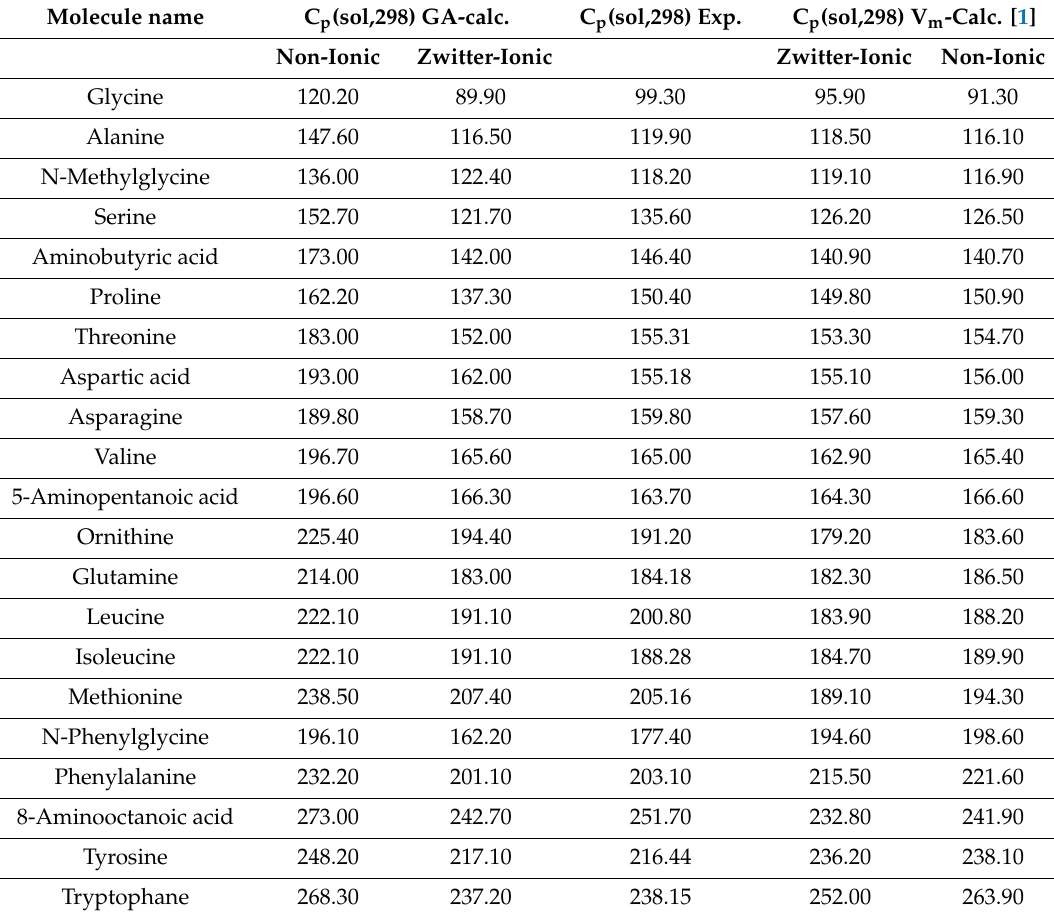
Table 10. Comparison of the Cp(sol,298) data of the ionic and the non-ionic forms of amino acids calculated by the present GA and the V m [1] method (in J / mol / K). Molecule